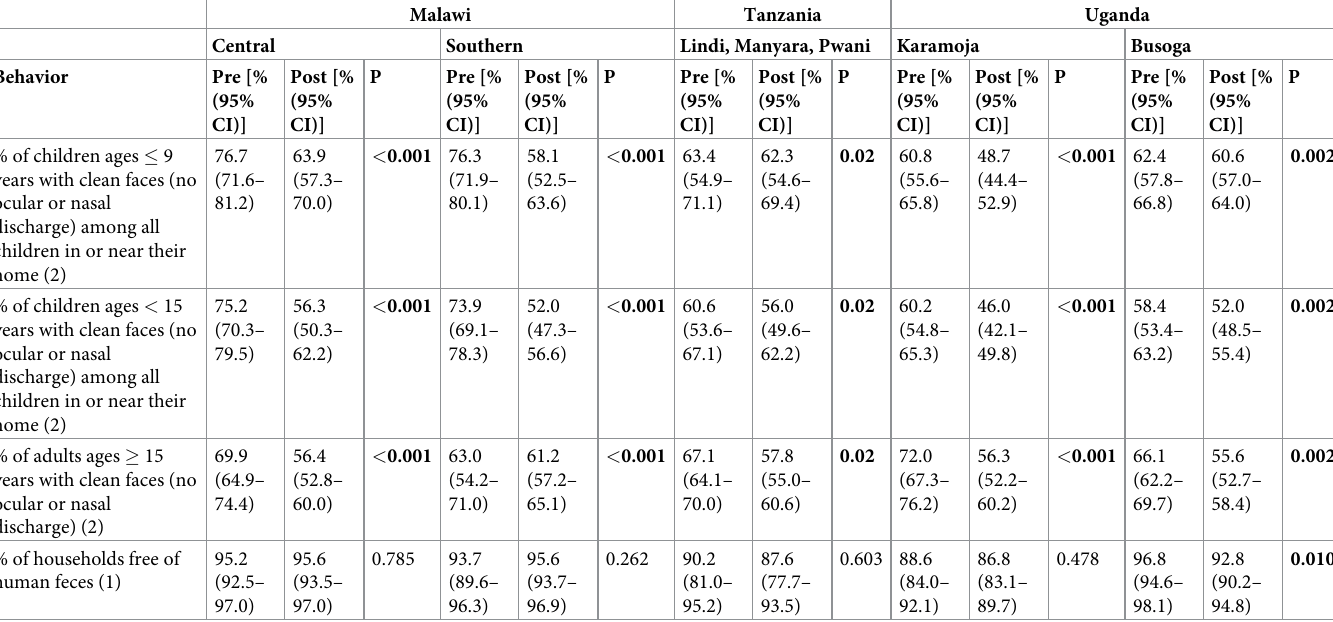
Table 7. Trachoma related behavior survey results by community evaluation unit at pre and